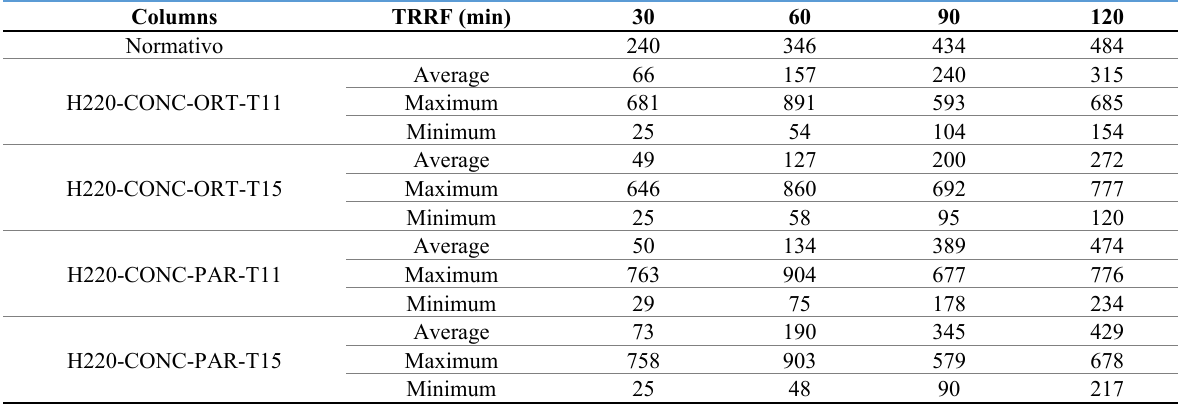
Table 8. Comparison of the temperatures obtained in the numerical model and the theoretical values for the concrete between the flanges of the columns inserted into walls.